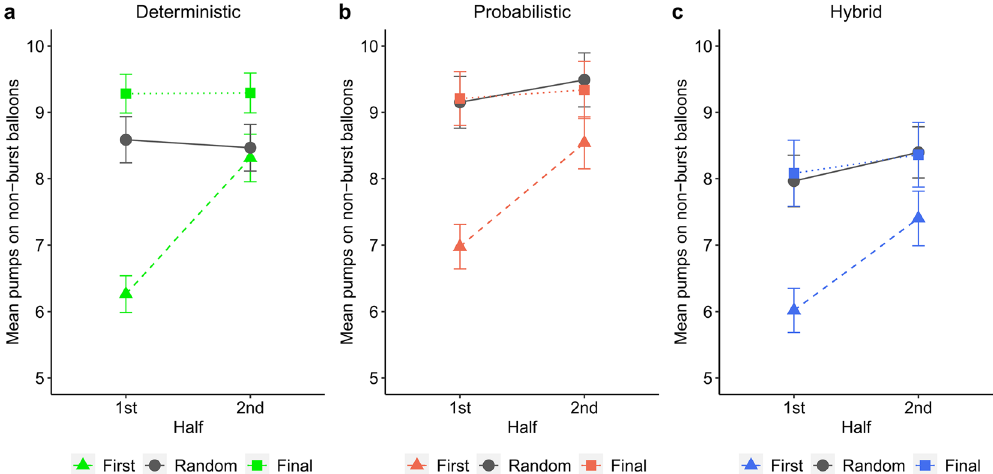
Figure 2. The effects of predictability and experience on risk taking. Group means of the mean number of pumps on non-burst balloons calculated for the 1st (balloons 1–15) and 2nd (balloons 16–30) halves of each phase (first, random, final) are presented separately in each condition (deterministic, probabilistic, hybrid). Error bars denote standard error of mean. Considering the 1st task half, pump number significantly increased across the first, random, and final phases in the deterministic ( p s ≤ 0.001) but not in the other conditions ( p s ≥ 0.855 between the random and final phases). Considering the 2nd task half, pump number was similar in the first and random phases ( p = 0.575) and higher in the final phase ( p s < 0.001) in the deterministic condition. Meanwhile, pump number was comparably higher in the random and final phases than in the first phase in the hybrid and probabilistic conditions ( p s ≤